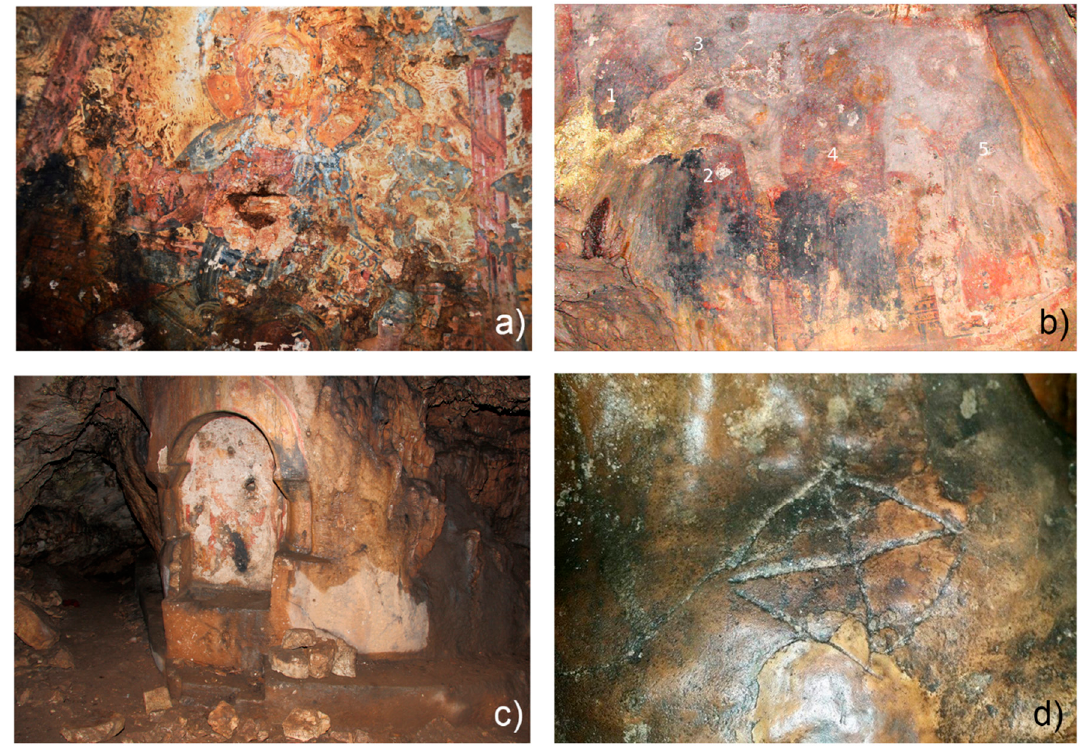
Figure 2. Wall paintings and ancient graffiti in the Sant’Angelo crypt. In detail: ( a ) the “Descent of the Holy Spirit and Christ Pantocrator” painting, ( b ) the “The Virgin and the Child flanked by the St. John and the St. Michael” painting (1. St. Michael’s wings, 2. St. Michael’s body, 3. St. Michael’s face, 4. Virgin and Child, 5. St. John), ( c ) the niche containing the “St. Michael the Archangel slaying the dragon” painting and ( d ) a cross incised in the crypt wall by pilgrims.